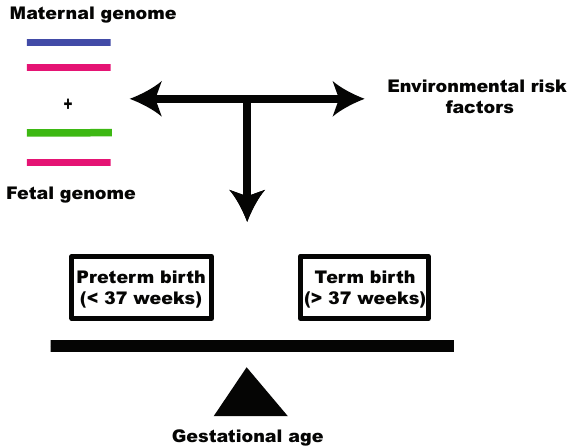
Fig. 2 Major risk factors that in fl uence the birth outcome. Interactions between maternal and fetal genome with environ- mental risk factors determine the period of gestation at delivery. Genome with high-risk alleles in the background of environmental risk factors leads to preterm